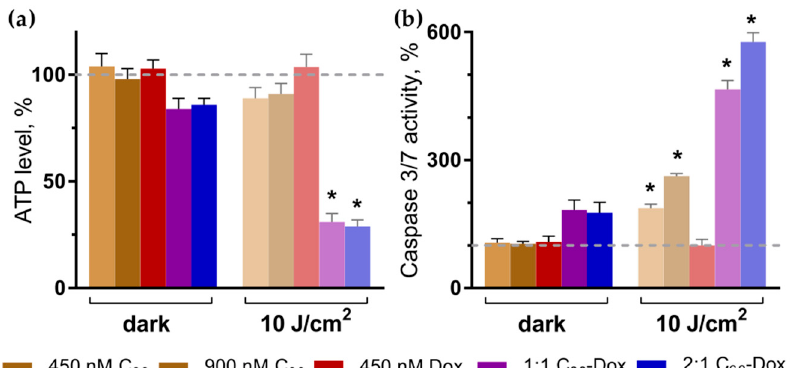
Figure 7. ATP level ( a ) and caspase 3/7 activity ( b ) in CCRF-CEM cells at 3 h after treatment. Treatment was done with either free C 60 and Dox or C 60 -Dox nanocomplexes in the dark or after irradiation with 10 J/cm 2 405 nm LED (* p ≤ 0.01 in comparison with the respective dark control).